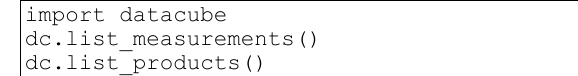
Figure 7. LISS III band 4